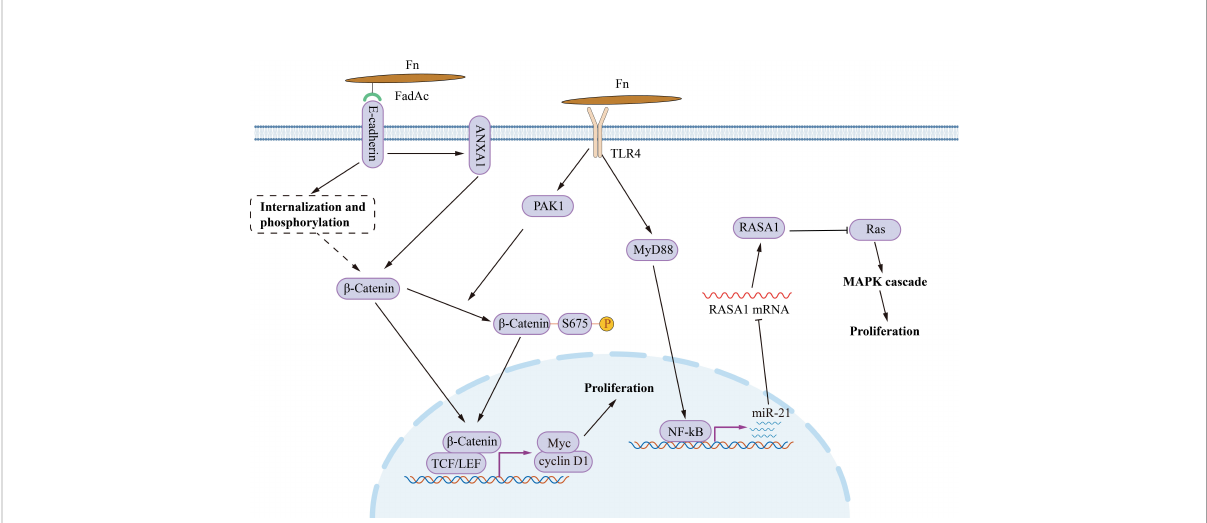
FIGURE 1 The mechanism of Fn promotes CRC cell proliferation. Fn adhesin FadAc binding to E-cadherin on CRC cell membrane leads to E-cadherin phosphorylation and internalization, enhancing the cytoplasmic accumulation and nuclear translocation of b -catenin. FadAc also up-regulates Annexin A1 via E-cadherin, activating b -catenin signaling. Fn lipopolysaccharides activate PAK1 through TLR4, and phosphorylates b -catenin at Ser675 by activating PAK1 (p-PAK1). Phosphorylation increases the nuclear accumulate of b -catenin. Nuclear b -catenin activates the transcription of downstream genes, such as CCND1, and MYC, and then promotes CRC cell proliferation. Fn activates TLR4/MYD88/NF- k B signaling to promotes miR-21 transcription. miR-21 activates the MAPK cascade by inhibiting RASA1, subsequently accelerates cancer cell